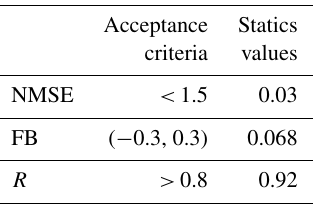
Table 3. Statistic metrics obtained for the validation of CFD results with experimental data (Meroney et al., 1996) and the acceptance criteria proposed by Chang and Hanna (2005) for urban configura-